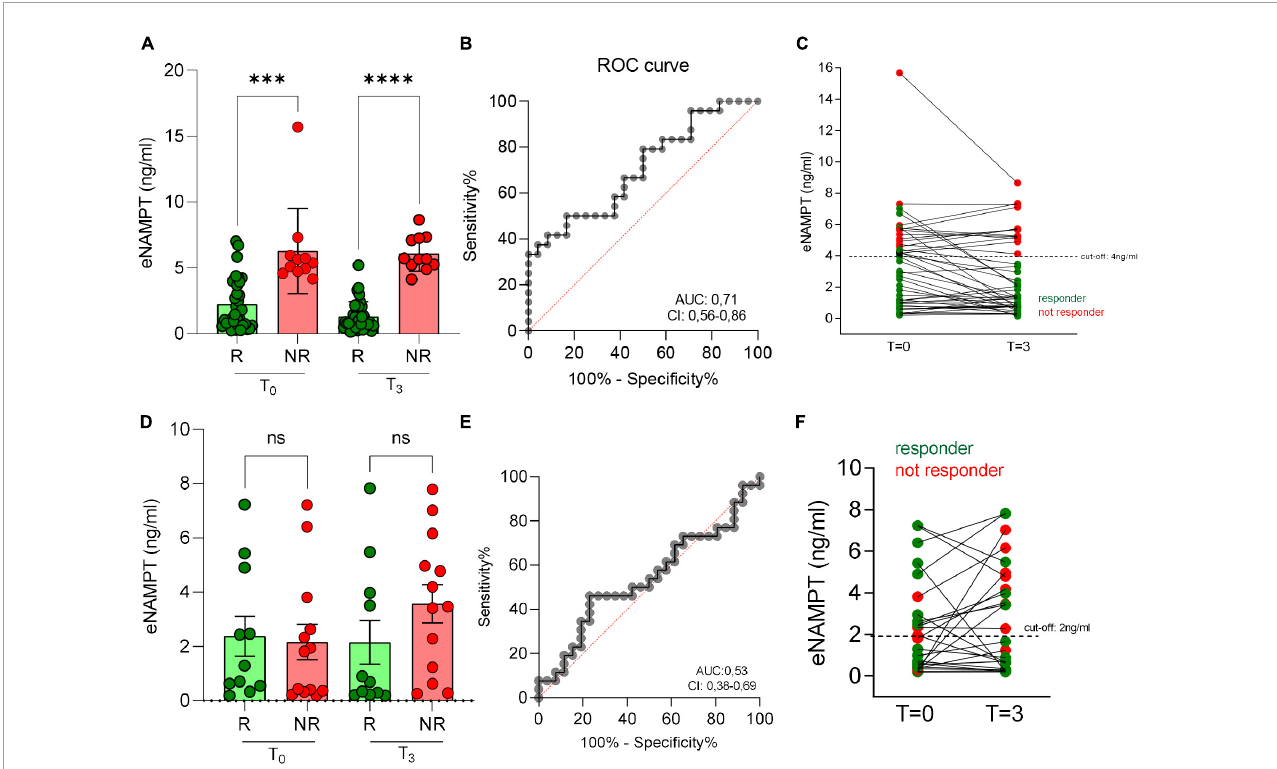
FIGURE3 Serum eNAMPT levels and response to anti-TNF treatment in IBD patients. (A) eNAMPT levels in responders (R) and non-responders (NR) to adalimumab at baseline ( T = 0) and after 3 months from the first infusion ( T = 3). N = 62: CD = 58, UC = 4. (B) ROC curve of adalimumab response. (C) eNAMPT levels in single patients after adalimumab infusion. Red dots represent NR, green dots represent R. N = 62: CD = 58, UC = 4. (D) eNAMPT levels in R and NR to vedolizumab at baseline ( T = 0) and after 3 months from the first infusion ( T = 3). N = 40: CD = 23, UC = 17. (E) ROC curve of vedolizumab response. (F) eNAMPT levels in single patients after vedolizumab infusion. N = 40: CD = 23, UC = 17. Red dots represent NR, green dots represent R. P -value: ∗∗∗ p < 0.001 and ∗∗∗∗ p <